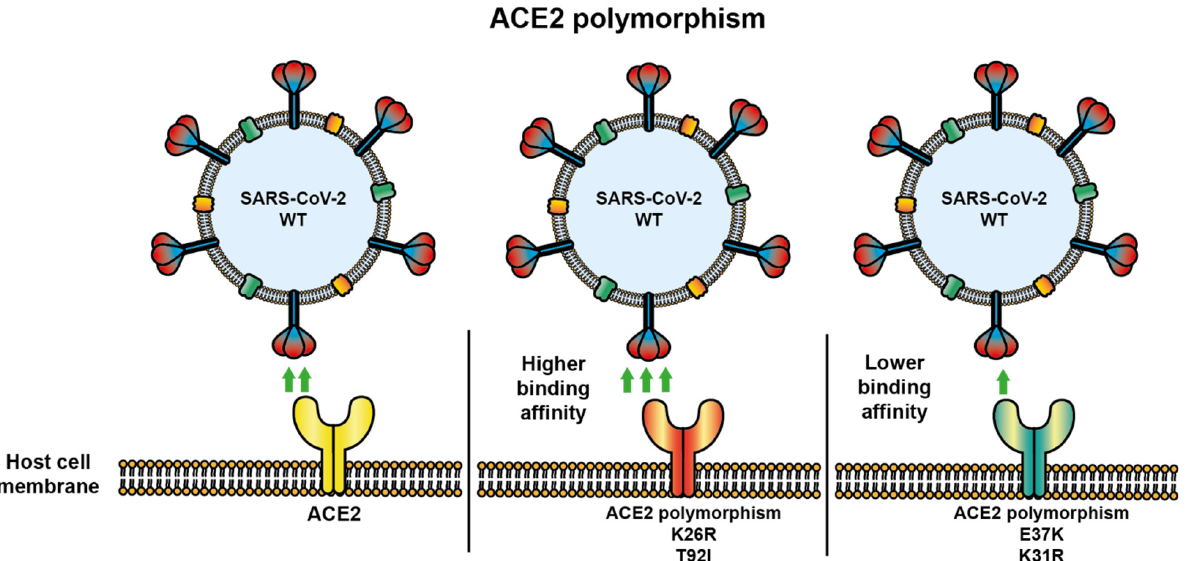
Figure 6. ACE2 polymorphisms modify their binding capability to SARS-CoV-2 glycoprotein S. ACE2 polymorphisms can also increase or decrease their binding affinity with SARS-CoV-2 glycoprotein S. Several ACE2 polymorphisms are shown interacting with SARS-CoV-2 wild type (WT). K26R and T29I ACE2 polymorphisms show a higher binding affinity to S glycoprotein. E37K and K31R ACE2 polymorphisms show a lower binding affinity to S glycoprotein, suggesting a lower infectivity to people with this last polymorphism.